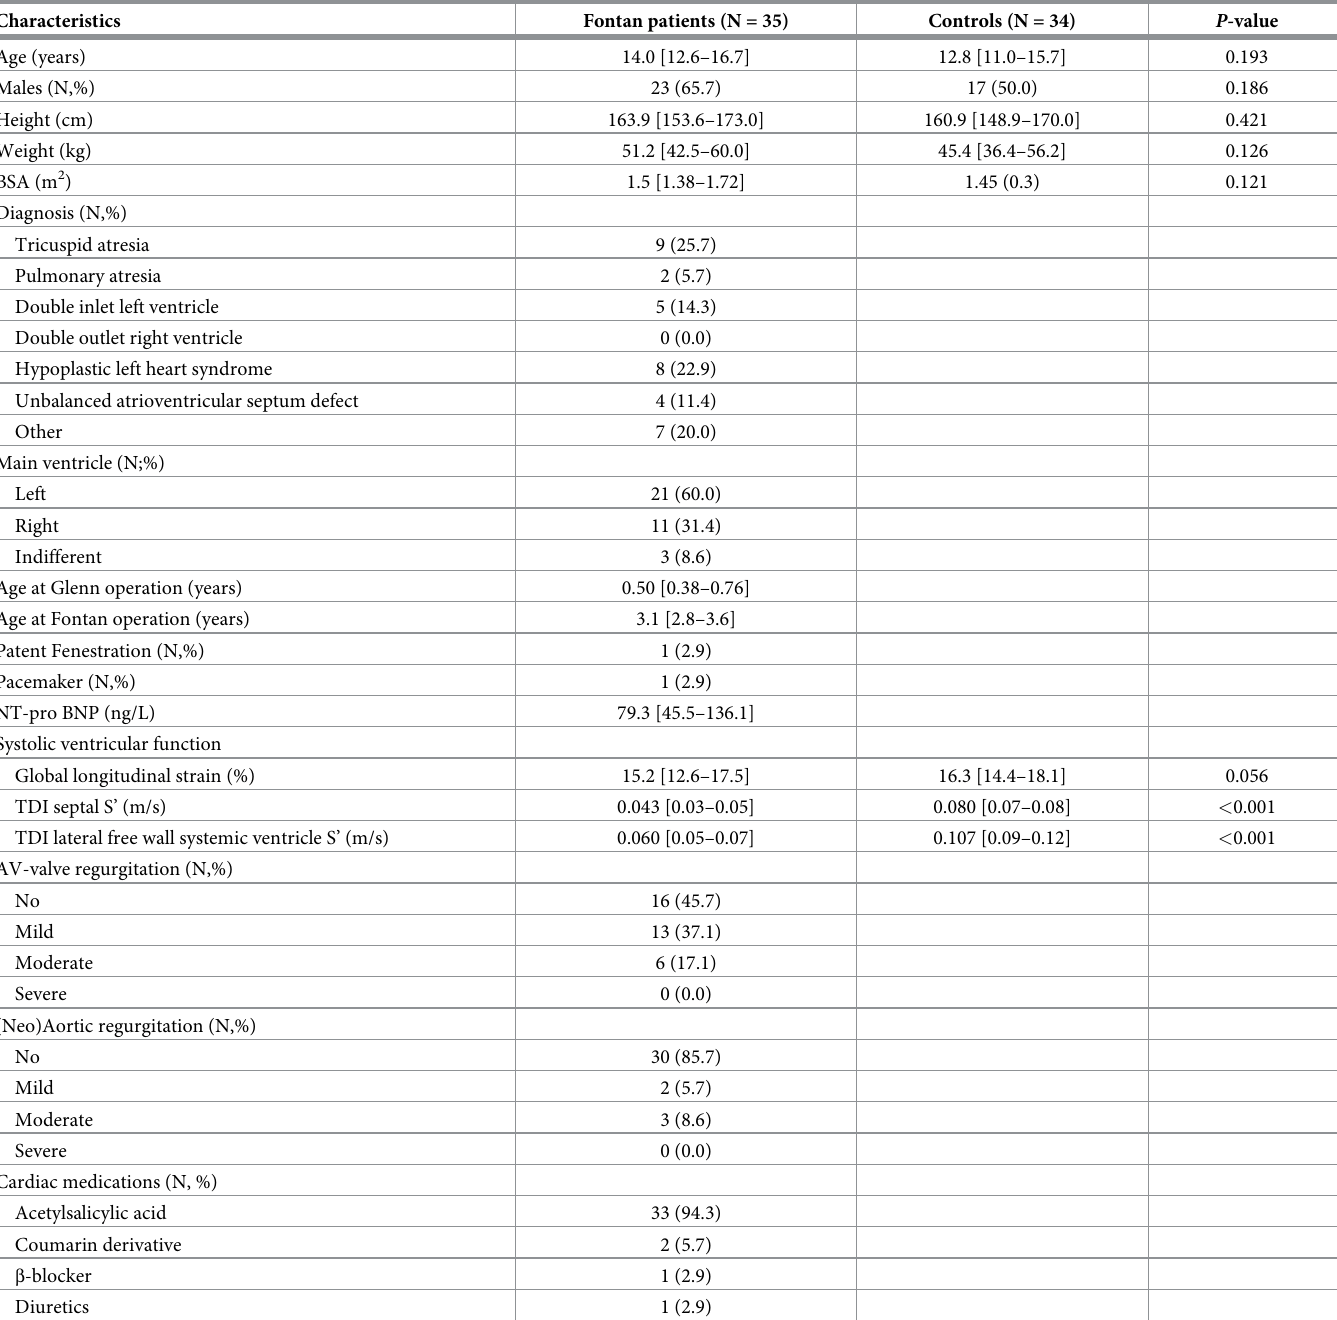
Table 1. Patient